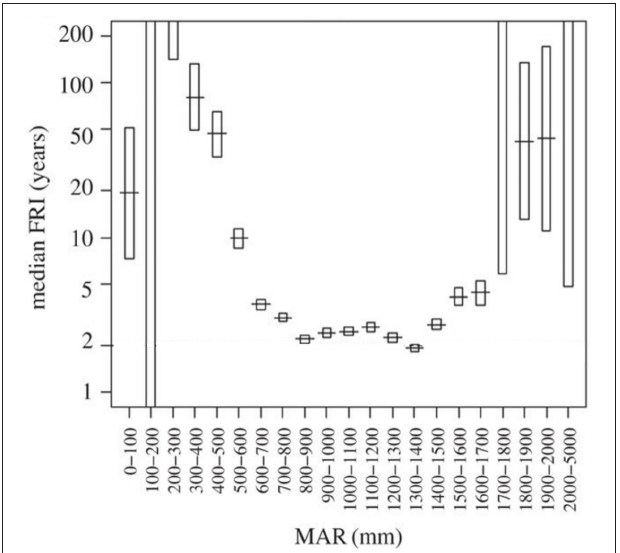
FIGURE 7 | Median fire return intervals (FRI) in savannas are strongly controlled by mean annual rainfall (MAR) by mediating regrowth rates of the grassy fuels. In African savannas fire return intervals are minimized when rainfall exceeds 900mm as the moisture of the fuel constrains flammability. Adapted from Archibald (2016). Managing the human component of fire regimes: lessons from Africa. Phil. Trans. R. Soc. B, 371:20150346. Adapted with permission of author (S. Archibald).